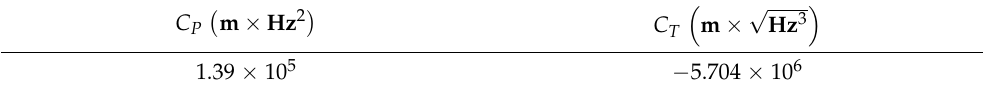
Table 2. Measured pressure-frequency coefficient and stress-frequency